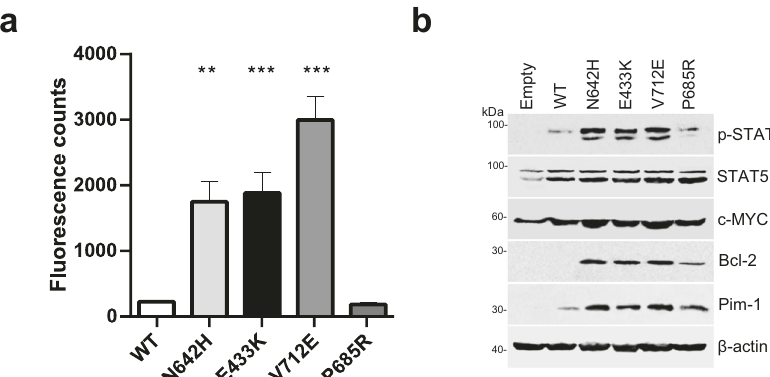
Fig. 3 Functional characterization of the novel STAT5B mutations. a Luciferase reporter assay revealed the STAT5B transcriptional activity induced by the E433K, V712E, and P685R mutations. By using STAT5B mutants-transfected HeLa cells, luciferase activities of STAT5B mutations were compared to the wt STAT5B data and are reported as luminescence counts. WT STAT5B : a negative control . STAT5B N642H mutation: a positive control. Statistical analysis was performed using two-way ANOVA. WT: wild-type; ** p < 0.001; *** p < 0.0001. b Protein expression in HeLa cells transiently carrying STAT5B mutants. The cells were serum-starved for 6 h after the transfection. Protein extracts were subjected to western blot assay with p-STAT5, STAT5, c-MYC, Bcl-2, and Pim-1 speci fi c antibodies. β -actin served as loading control. Data are representative of the three independent (Fig. 4c, p adj < 0.05, Bonferroni corrected Mann – Whitney test).